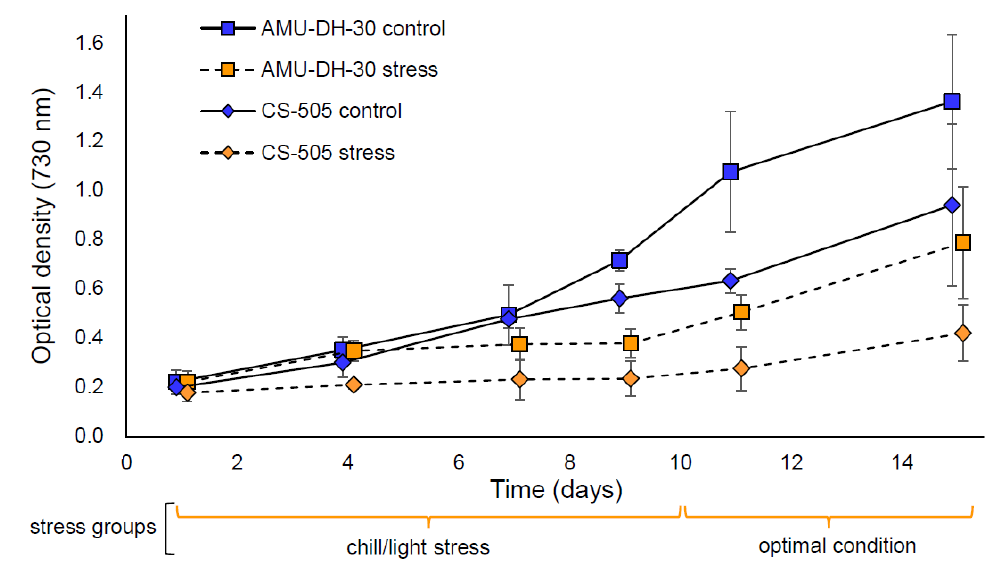
Figure 1. The growth of Raphidiopsis raciborskii AMU-DH-30 (squares) and CS-505 (rhombs) strains in the control conditions and under the chill / light stress (10 ◦ C and 100 µ mol of photons m − 1 s − 1 for 10 d). The blue colour with solid lines represents control groups, the orange colour with dashed lines represents the stress group. Statistically significant di ff erences between: (1) AMU-DH-30 control and AMU-DH-30 stress in 9, 11, and 15 d; (2) CS-505 control and CS-505 stress in 7, 9, 11, and 15 d; (3) AMU-DH-30 stress and CS-505 stress in 11 and 15